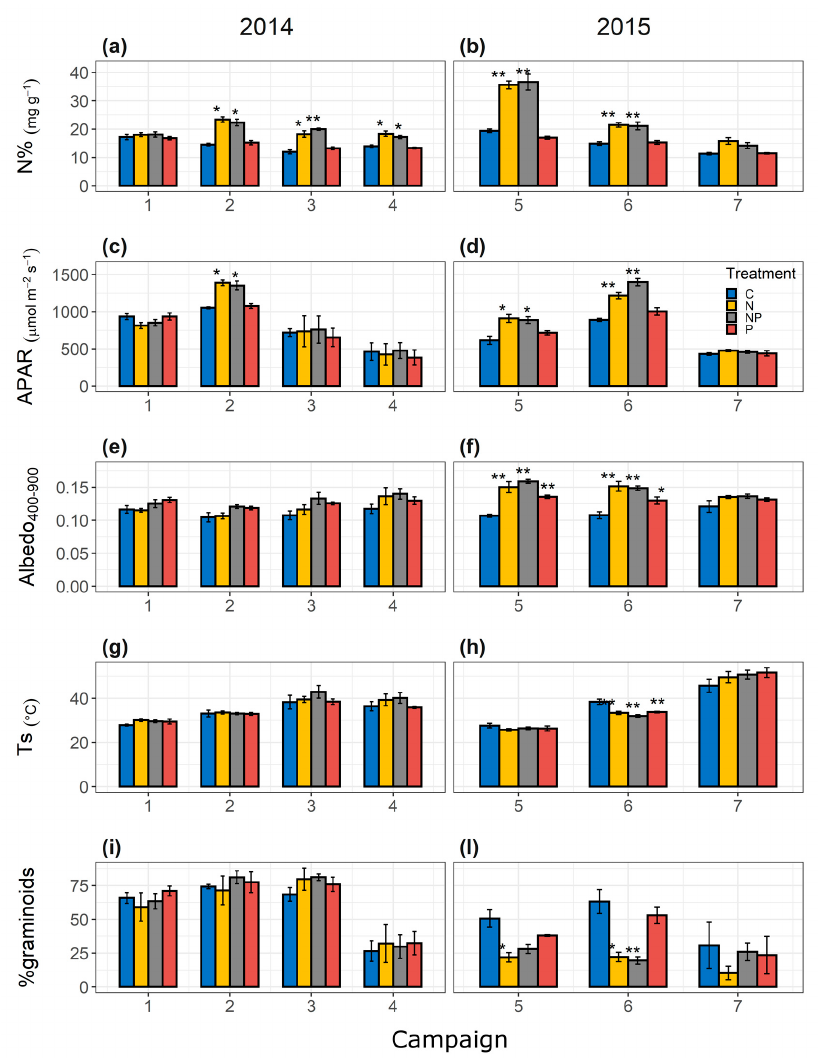
Figure 3. Bar graph representing di ff erences among treatments (control treatment, C; nitrogen treatment, N; nitrogen and phosphorus treatment, NP; and control treatment, C) of Canopy nitrogen content (N%) in 2014 ( a ) and 2015 ( b ); absorbed photosynthetic active radiation (APAR) in 2014 ( c ) and 2015 ( d ); Albedo 400–900 in 2014 ( e ) and 2015 ( f ); Surface Temperature (Ts) in 2014 ( g ) and 2015 ( h ); and graminoids relative abundance (%graminoids) in 2014 ( i ) and 2015 ( l ). Data are divided among campaigns. Bar graphs represent means and error bars represent 1 standard error. Group di ff erences in ( e – h ) were analyzed with ANOVA test and individual di ff erences among groups were evaluated with Tukey HSD post hoc test. Group di ff erences in ( a , b , i , l ) were analyzed with ANOVA with the Welch correction and individual di ff erences among groups were evaluated with the Games–Howell post hoc test. “*” refers to a significant di ff erence from the control treatment with p value < 0.05 and “**” refers to a significant di ff erence from the control treatment with p value <